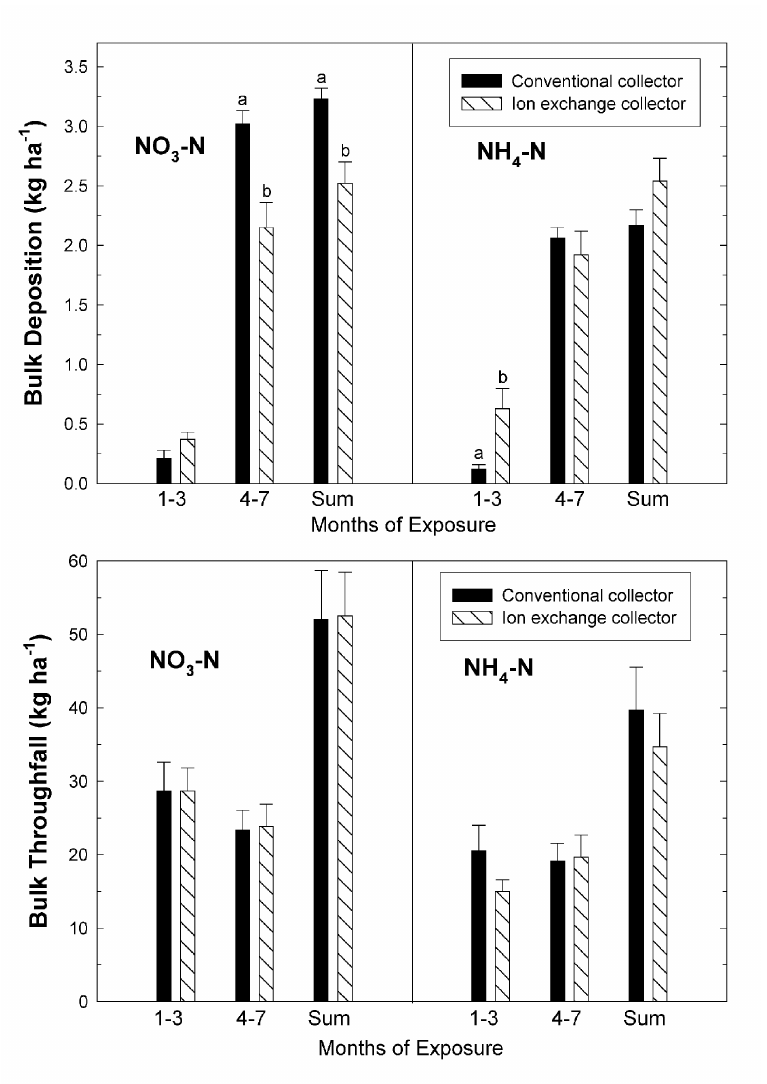
FIGURE 3 . Comparison of deposition of NO 3 -N and NH 4 -N to conventional throughfall solution collectors and ion exchange resin collectors under pine trees and in open areas (bulk deposition) at Camp Paivika, a high deposition site in the San Bernardino Mountains. The first set of collectors was exposed for 3 months, followed by another set exposed for 4 months. Sum refers to total deposition during the two exposure periods combined. Letters above the error bars indicate significant differences ( p < 0.05) in deposition between the collector types for that exposure period (n = 20 for throughfall collectors and n = 4 for bulk deposition collectors in open